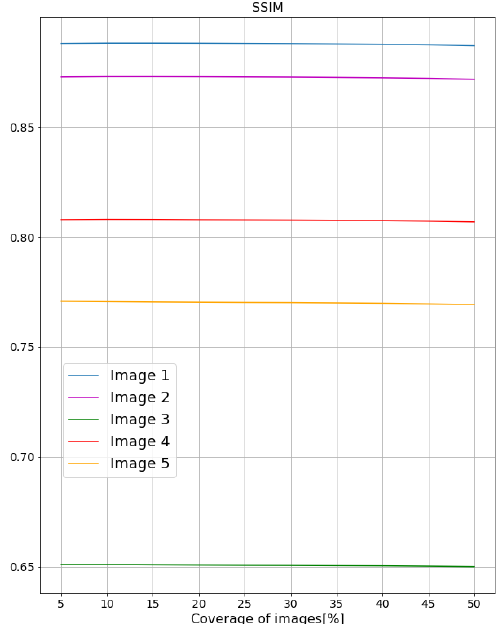
Figure 11. SSIM values for the analyzed images.